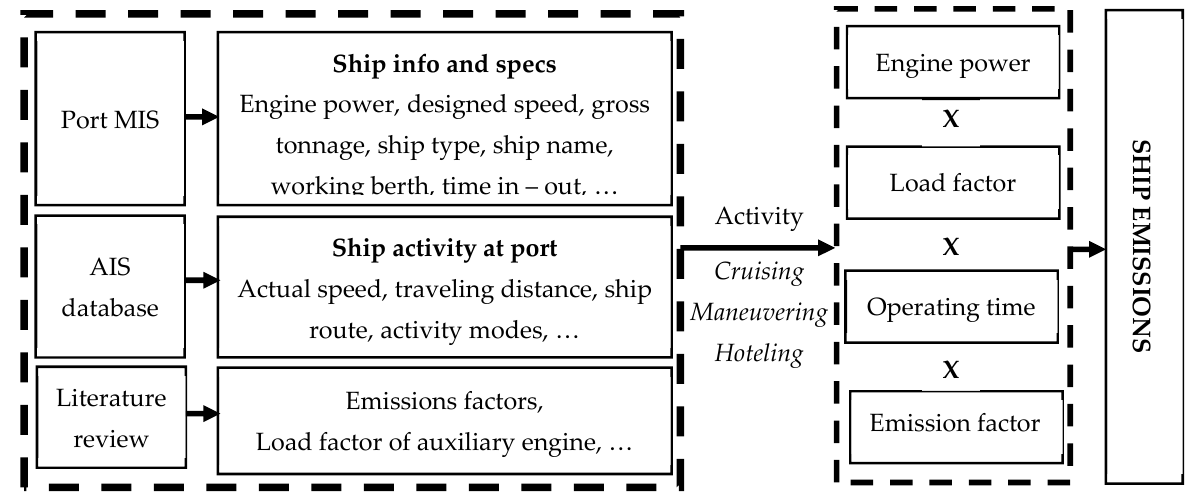
Figure 2. Data analysis process for ship emissions calculation.